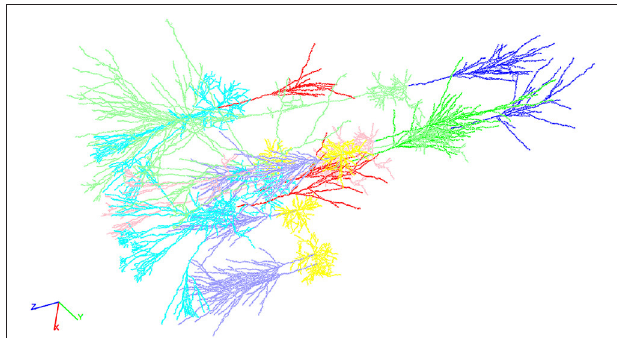
FIGURE 2 | An exemplary neocortical network consisting of a total of ten individual cells synthetically generated with NeuGen. The cellular composition of the displayed network is identical to the networks described in Table 1 above. Visualization comprises the different cell types distinguishable by color: axons of L4 spiny stellate (lavender), axons of L2/3 pyramidal (red), axons of L5A pyramidal (bright green), axons of L5B pyramidal (blue), dendrites of L4 spiny stellate (yellow), dendrites of L2/3 pyramidal (cyan), dendrites of L5A pyramidal (rose), dendrites of L5B pyramidal (light green), somata of L4 spiny stellate (ocher), somata of L2/3 pyramidal (orange), somata of L5A pyramidal (light blue), and L5B pyramidal (brown).